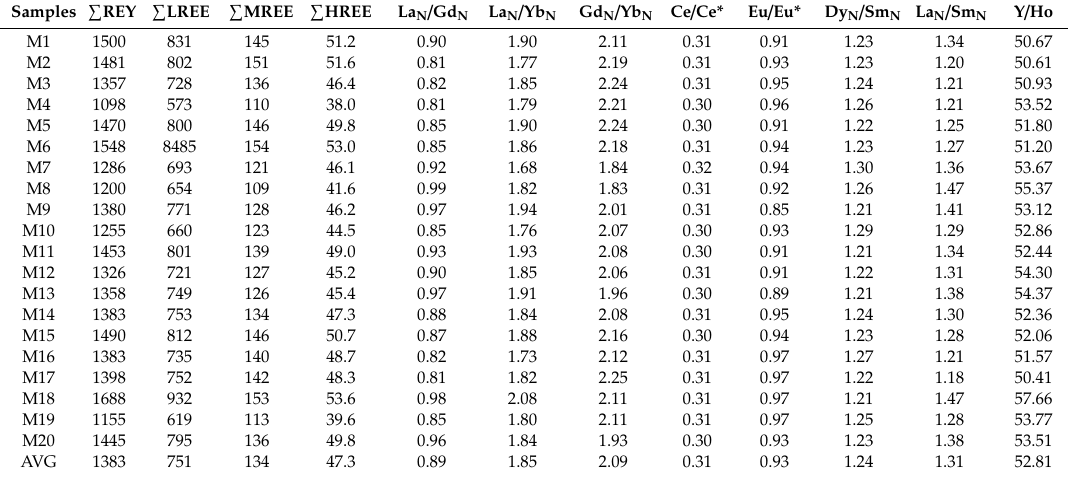
Table 3. The from the intraclastic apatite